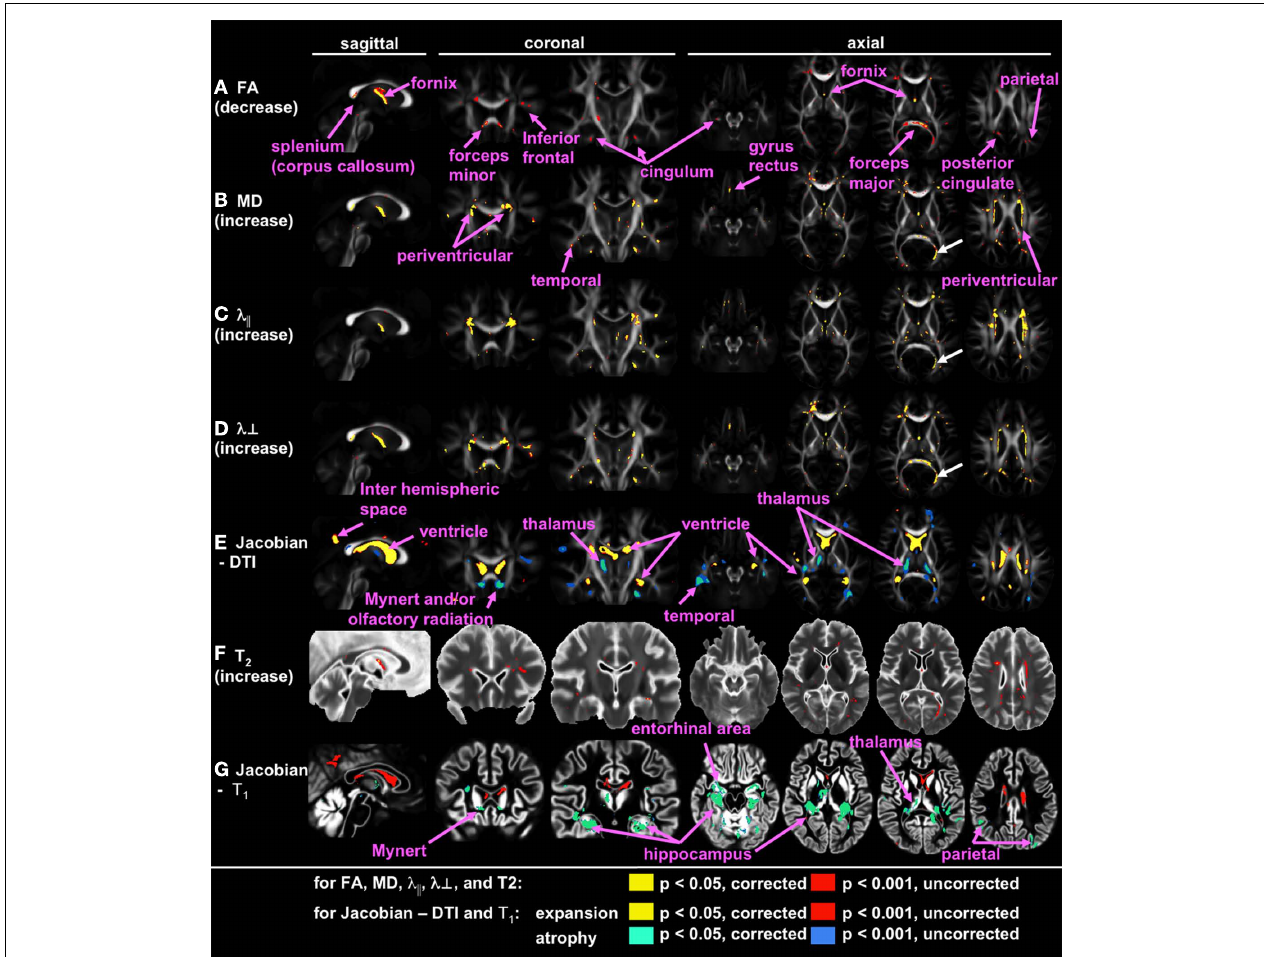
FIGURE 2 |Voxel-based group comparison betweenAD and NC. Areas with signal or volume alterations in AD compared to NC are shown as colored maps, overlaid on an averaged FA map (A–E) , an averagedT 2 map (F) , and an averaged GM segmentation map (G) , created from all 63 images. (A) : Areas with reduced FA. (B) Areas with increased MD. (C) Areas with increased λ || . (D) Areas with increased λ ⊥ . (E) Areas with an increased and